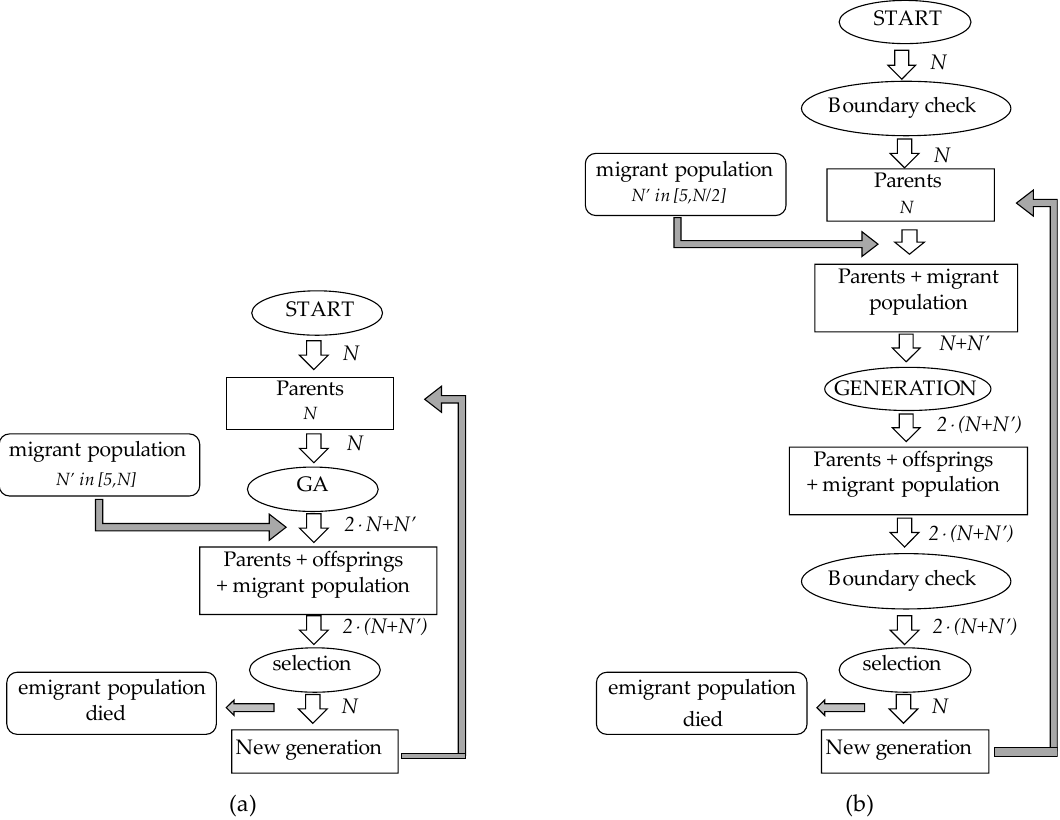
Figure 6. Optimization flow chart ( a ) M-NSGA and ( b ) MP-NSGA with boundary check.